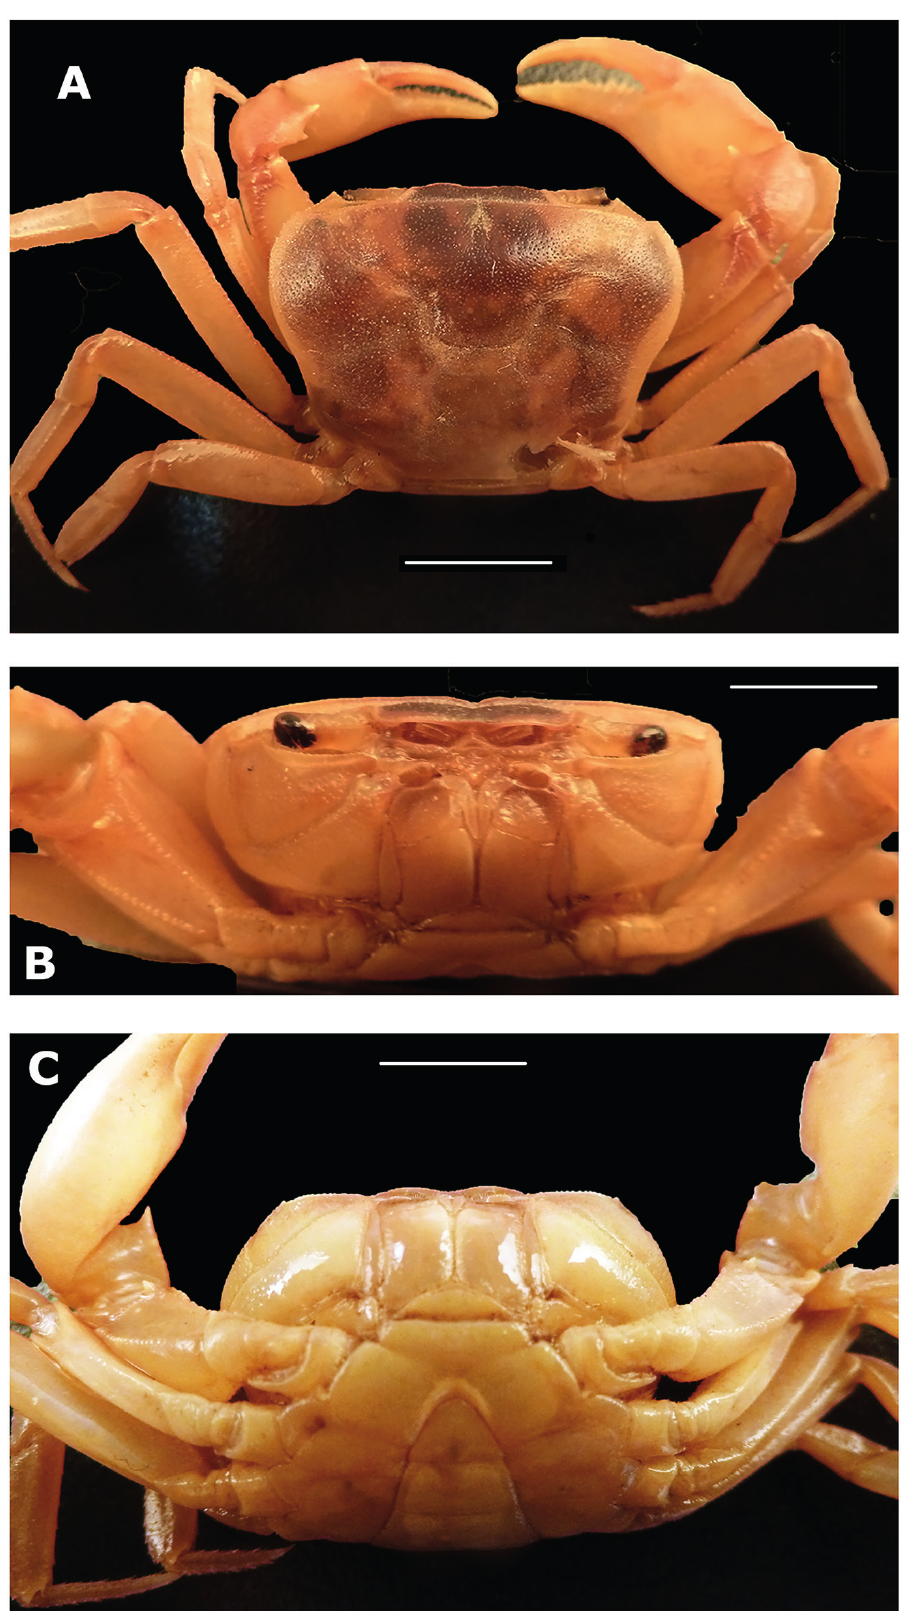
Figure 1. Potamonautes gorongosa, new species, male holotype (CW 25.4 mm) from Gorongosa National Park, Sofala Province, Mozambique (NMU PN 2014). A, carapace, dorsal view; B, carapace, frontal view; C, carpus and merus of right pereiopod 1 (cheliped), dorsal view. Scale bar = 8.9 mm,